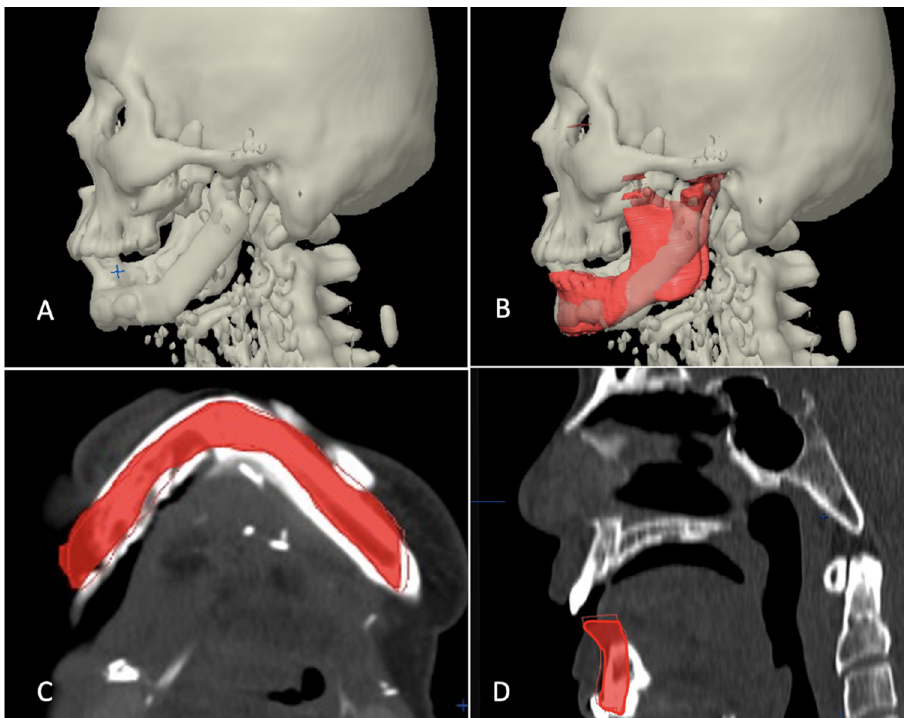
Figure 9. Superimposition of planned and postoperative image in category II. ( A ) 3-dimensional view of outcome after reconstruction. ( B ) Superimposition of virtual plan (purple color) and post- operative data. ( C , D ) Axial view showing good match of reconstructed fibula to simulated mandi- ble.